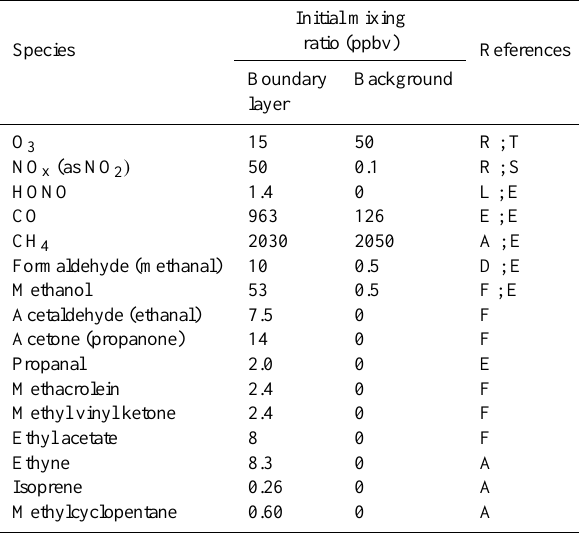
Table 1. Initial (midnight) values of inorganics, OVOCs and se- lected VOCs defined in the Mexico City box model.